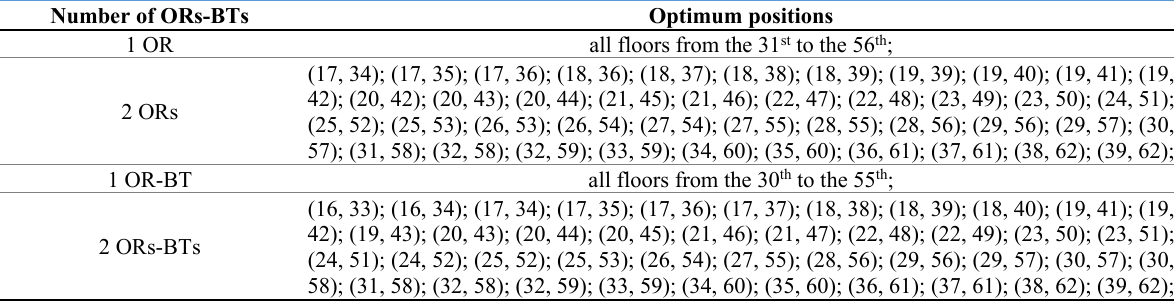
Table 7. Optimum positions resulting from multi-objective optimization Number of